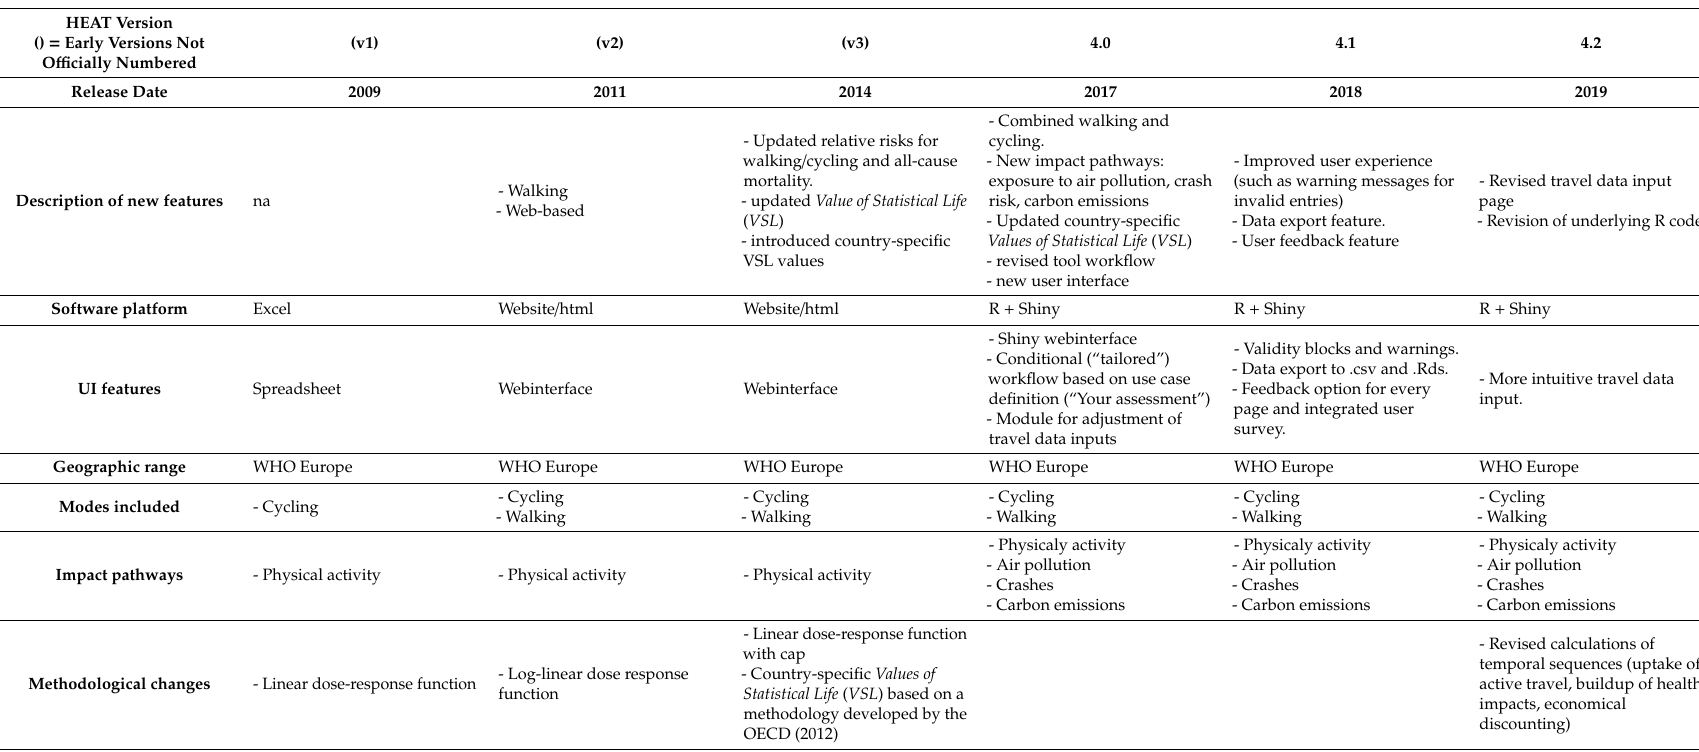
Table 1. HEAT versions